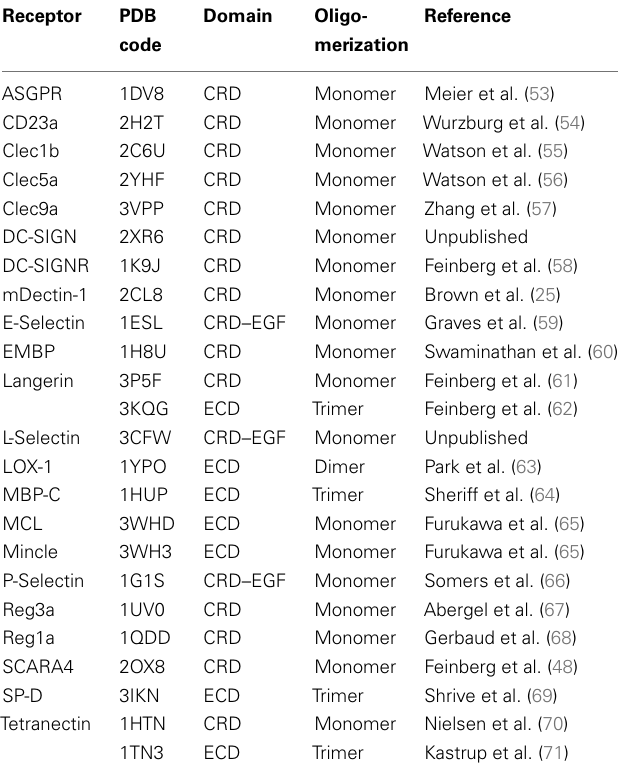
Table 1 | List of analyzed CTLR structures .